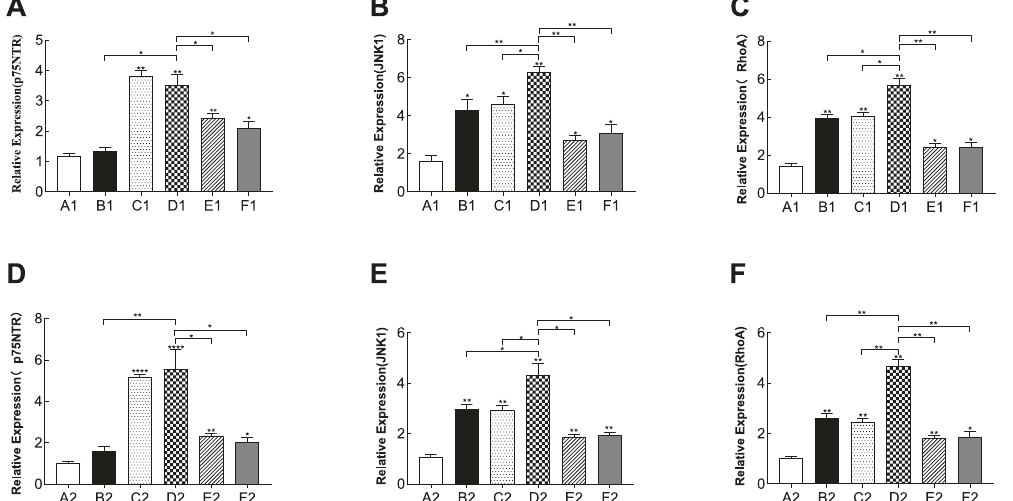
Fig. 5 Reverse transcriptase quantitative PCR (RT-qPCR) assay to detect the mRNA levels of p75NTR, JNK1 and RhoA in all groups ( n = 3 per subgroup). A p75NTR mRNA level of prefrontal cortical neurons. B JNK1 mRNA level of prefrontal cortical neurons. C RhoA mRNA level of prefrontal cortical neurons. D p75NTR mRNA level of hippocampal neurons. E JNK1 mRNA level of hippocampal neurons. (F) RhoA mRNA level of hippocampal neurons. Con control, OGD oxygen-glucose deprivation, CS corticosterone. A1: Con; B1: OGD; C1: CS; D1: OGD + CS; E1: OGD + CS + re-p75NTR; F1: OGD + CS + siJNK1; A2: Con; B2: OGD; C2: CS; D2: OGD + CS; E2: OGD + CS + re-p75NTR; F2: OGD + CS +